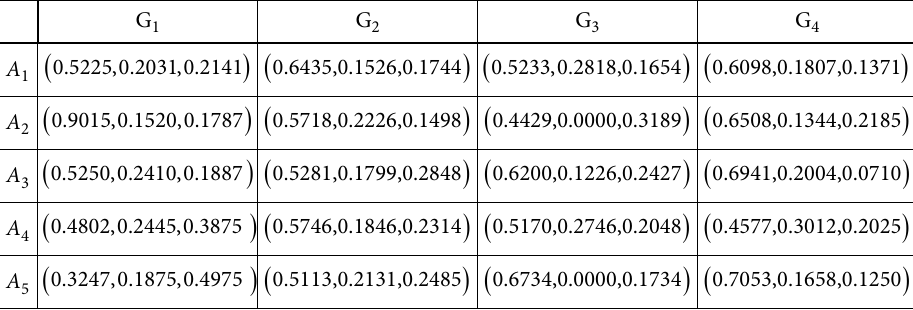
Table 4. The fused values by using PFWA operator G 1 G 2 G 3 G